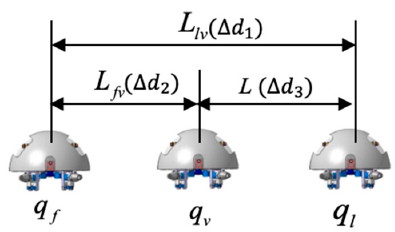
Figure 15. Relative distance between robots.